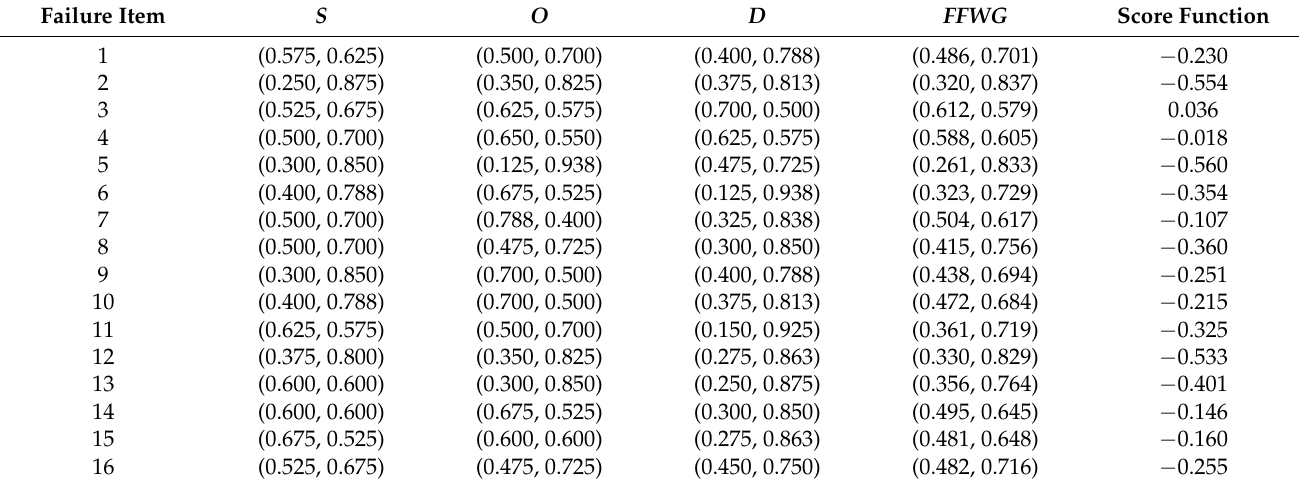
Table 8. The results of Fermatean fuzzy weighted geometric ( FFWG ) values by typical